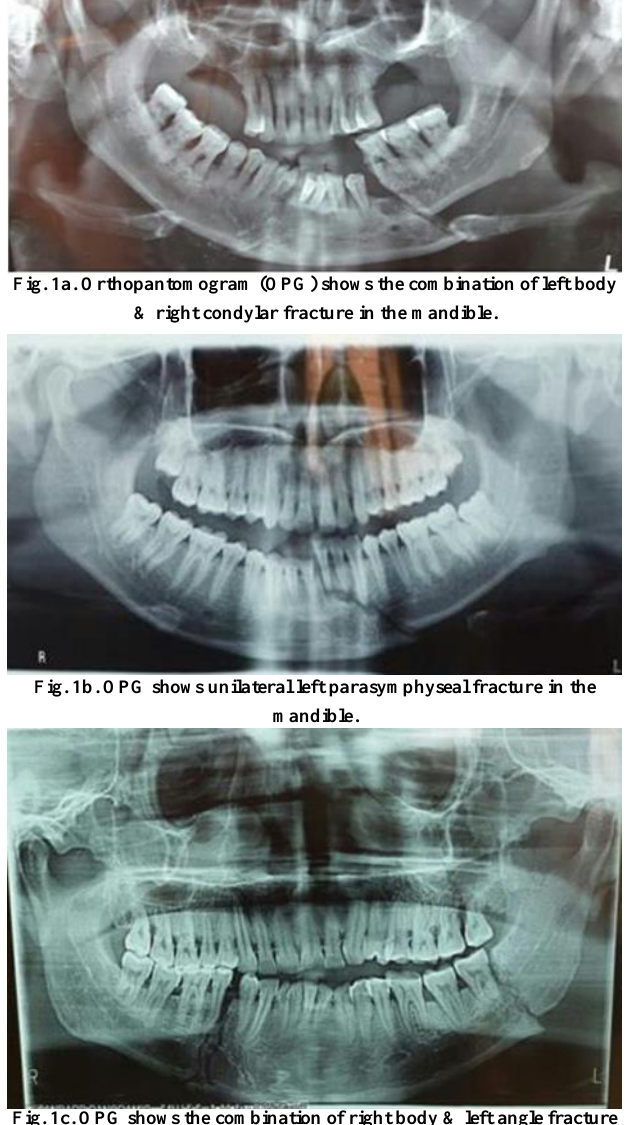
Fig. 1f. 3D-CT shows a comminuted fracture in the left side of the mandibular